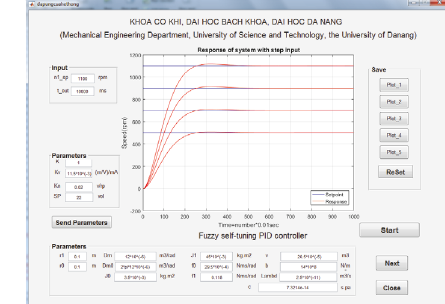
Figure 12: Simulating result on Matlab/Guide.